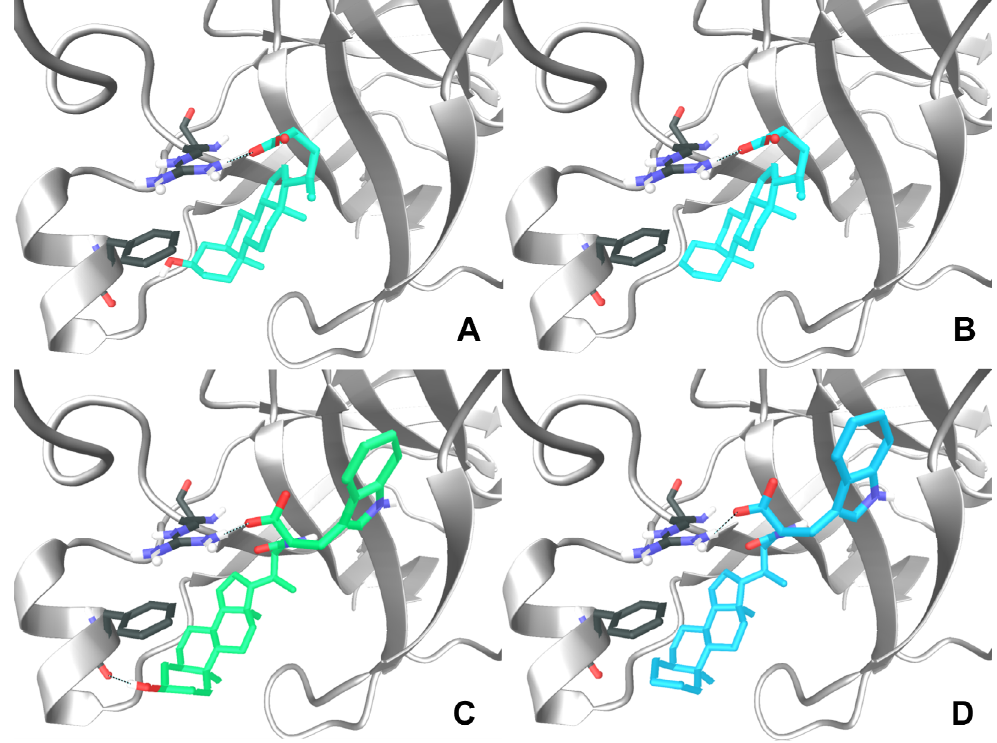
Figure 2. Lithocholic acid ( A ), cholanic acid ( B ), PCM 126 ( C ) and compound 8 ( D ) docked within the ligand binding domain of the EphA2 receptor. Secondary structure elements of EphA2 are colored in white, while carbon atoms of Arg103 and Phe156 are colored in grey (oxygens in red; nitrogens in blue, hydrogens in white). H-bond between the carboxylic acid of the ligands ( A – D ) and the guanidine group of Arg103 are highlighted with a dotted blue line. H-bond between the 3 α -hydroxyl group of PCM126 and the backbone oxygen of Phe156 is depicted with a dotted green-line ( C